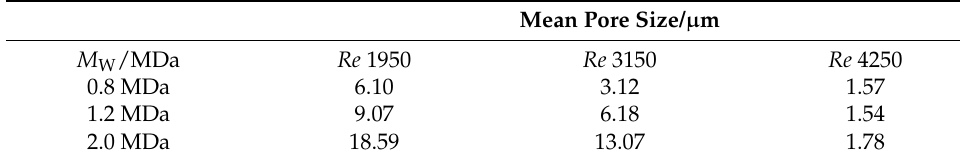
Table 5. Results of mean pore size measurements.